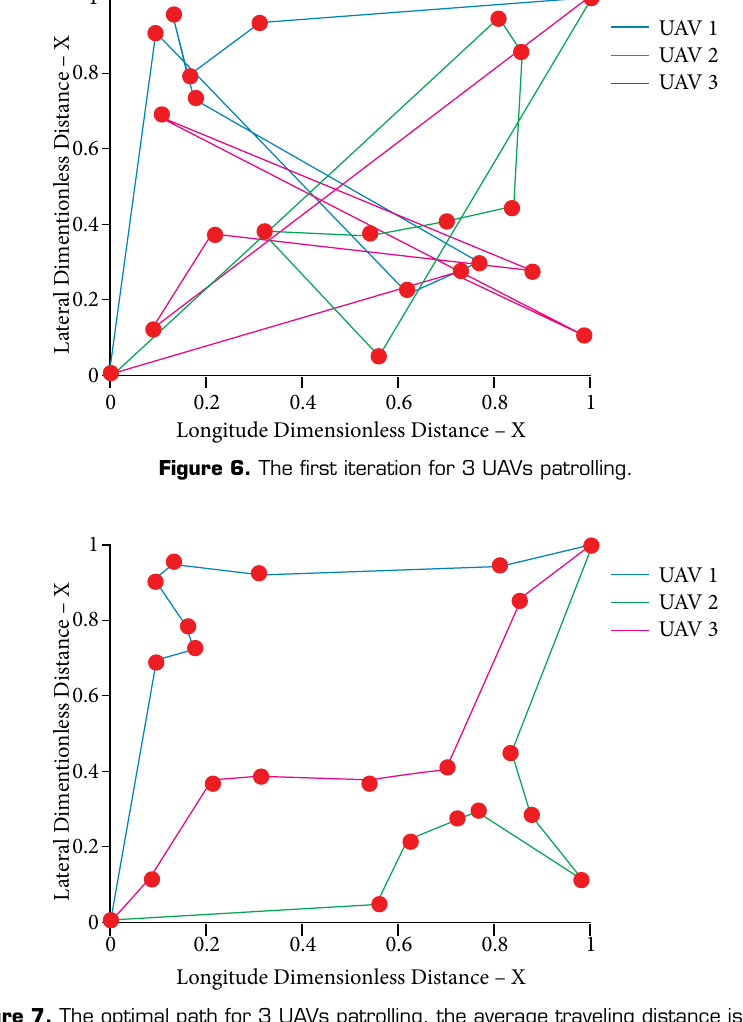
Figure 7. The optimal path for 3 UAVs patrolling, the average traveling distance is 1.8966.